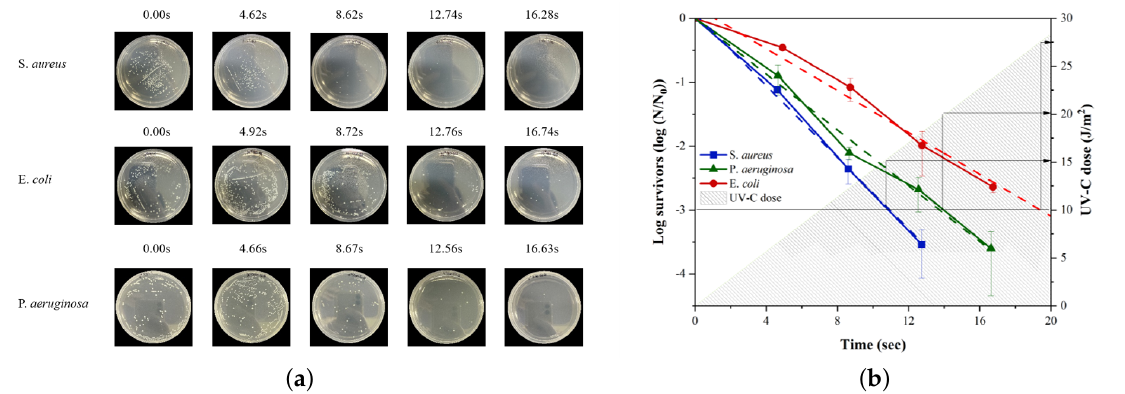
Figure 5. Stationary UV-C (254 nm) sterilization experiment with a prolonged exposure duration at a 1 m distance: ( a ) bacterial plates and ( b ) sterilization effect (log survivors) graph where the duration of eh UV-C application varies. Given that the accumulative UV-C energy exposed onto the sample is